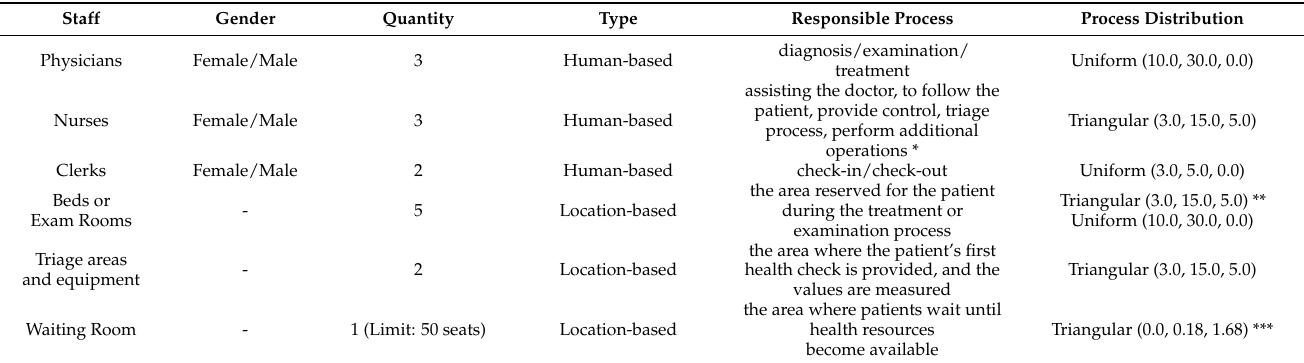
Table 3. Healthcare resources employed in the ED unit and their